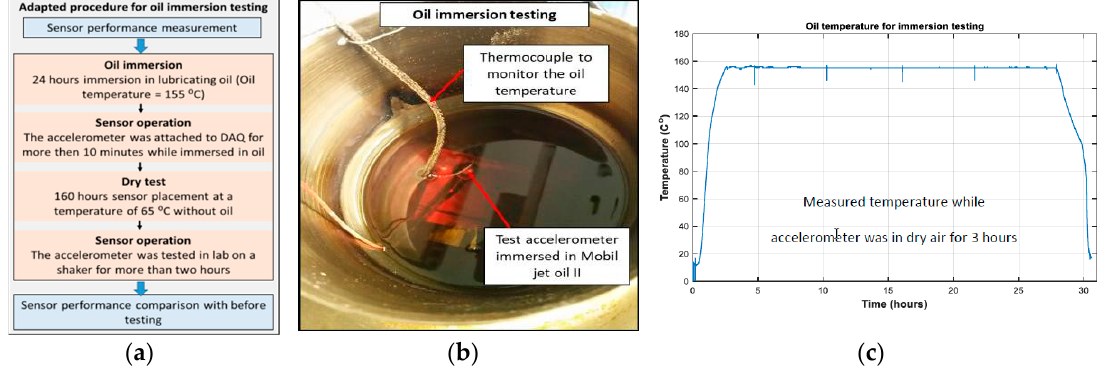
Figure 2. ( a ) Schematic for adapted methodology for oil immersion and endurance testing. ( b ) Photograph for accelerometer immersed in oil. ( c ) Measured oil temperature for accelerometer immersion testing.